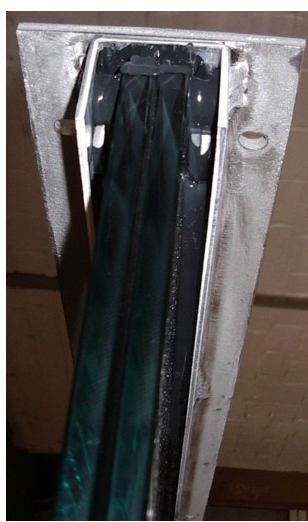
Figure 3a: Detail at the top edge and bonding - drawing. Figure 3b: Detail at the top edge and